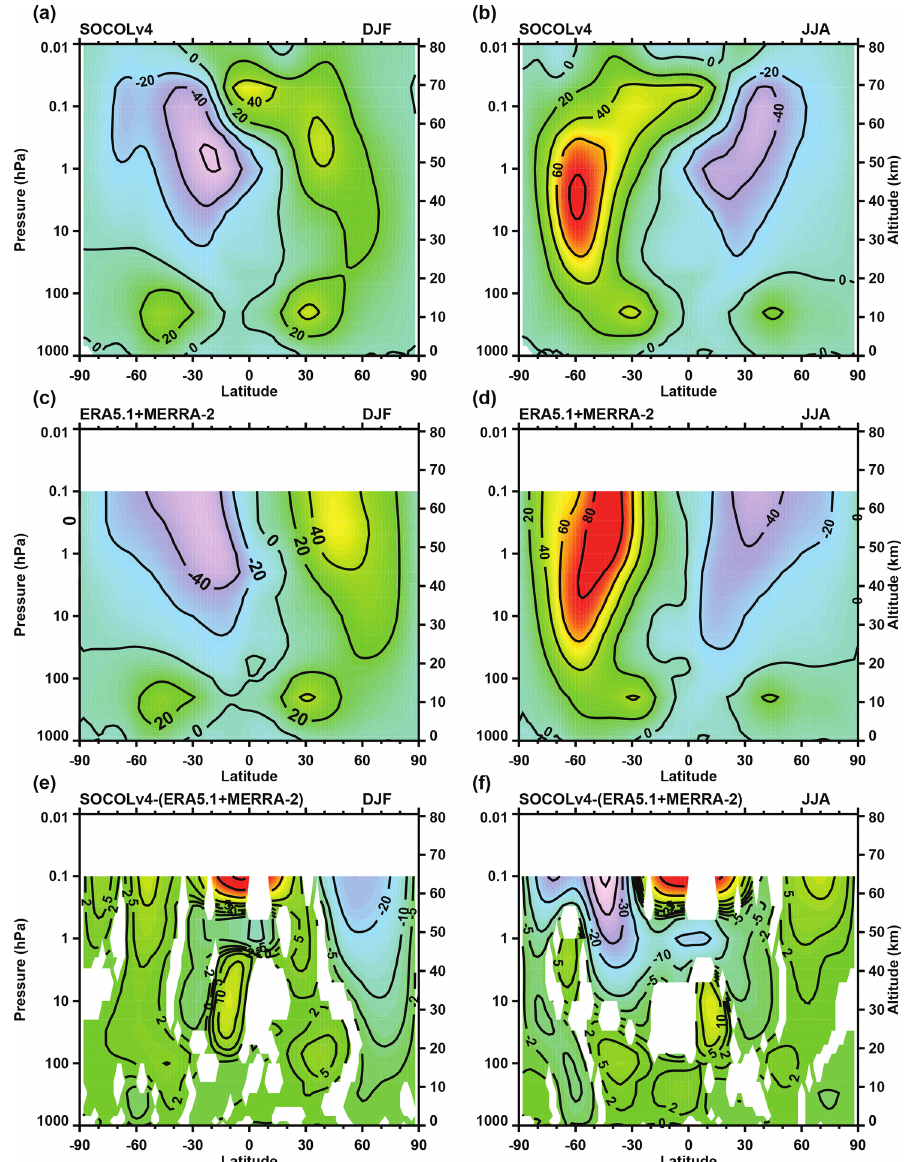
Figure 6. Zonal mean zonal wind climatology (ms − 1 ) for DJF (a, c, e) and JJA (b, d, f) simulated with SOCOLv4 (a, b) , mean of ERA5.1 and MERRA-2 reanalysis (c, d) , and differences between simulated and reanalysis data (e, f) . Contour intervals for the difference are − 30, − 20, − 10, − 5, − 2, 2, 5, 10, 20, 30ms − 1 . White areas denote regions where the difference between model and reanalysis data is not statistically significant at the 95% confidence level calculated with a Student’s t